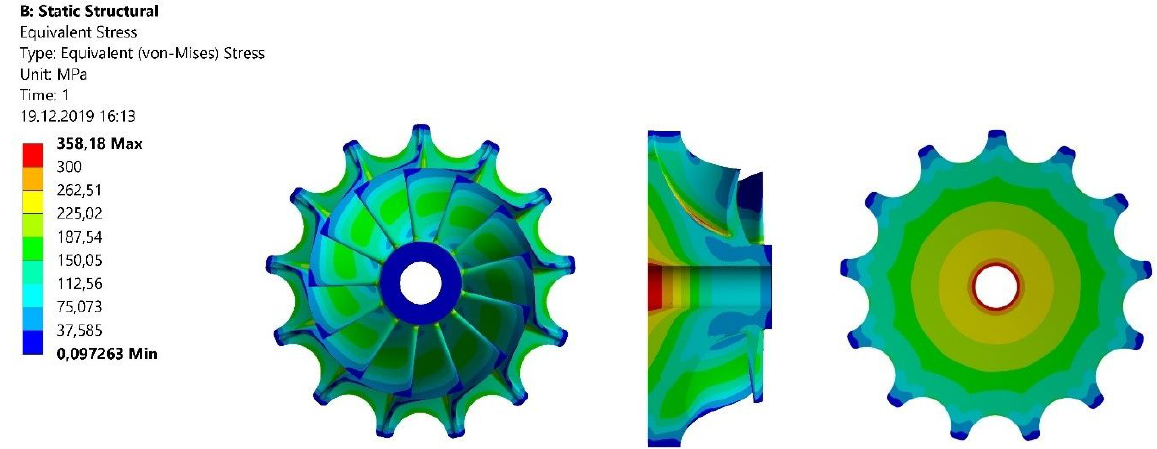
Figure 27: Front, side and rear view of turbine disc – method 3 ceramic (rotational speed – 96,000 rpm; temperature – 600 ∘ C)